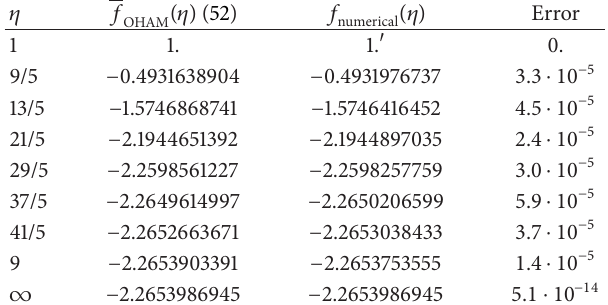
󸀠 (𝜂) Table 8: Comparison between the second expression of the first- obtained from 󸀠 order approximate solutions 𝑓(𝜂) given by (52) obtained by OHAM (𝜂)− OHAM and numerical results for 𝛾 = 1 and 𝑆 = −2 (error = |𝑓 (𝜂)| ). 𝑓 numerical